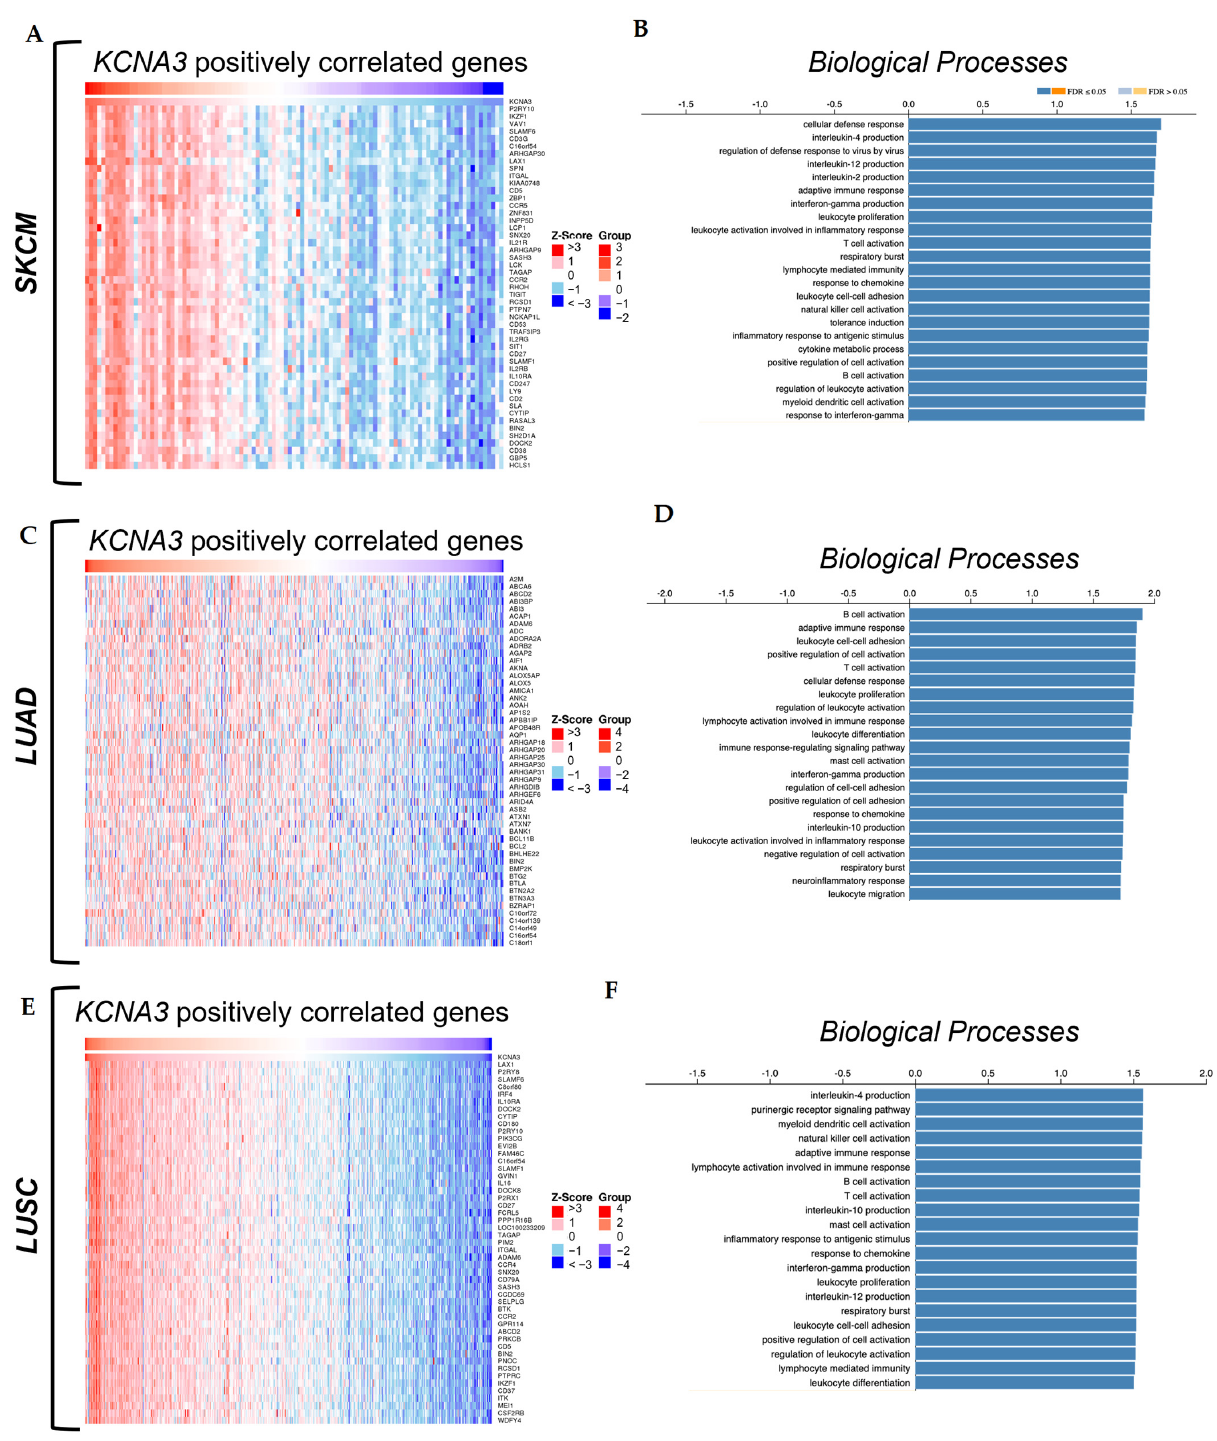
Figure 4. KCNA3 correlated differentially expressed genes and related pathways. The top 50 positively KCNA3 co-expressed genes were mapped using the TCGA SKCM ( A , B ), LUAD ( C , D ), and LUSC ( E , F ) datasets in the LinkedOmics database, according to their ranking based on their Z-score through Spearman correlation analysis. GO BP (biological processes) analysis was obtained through gene ontology enrichment analysis performed on LinkedOmics, using the top 1000 KCNA3 positively correlated genes based on their p -value. Data were plotted as per fold enrichment, for the − log10 of the false-discovery rate (FDR) and the p -values,